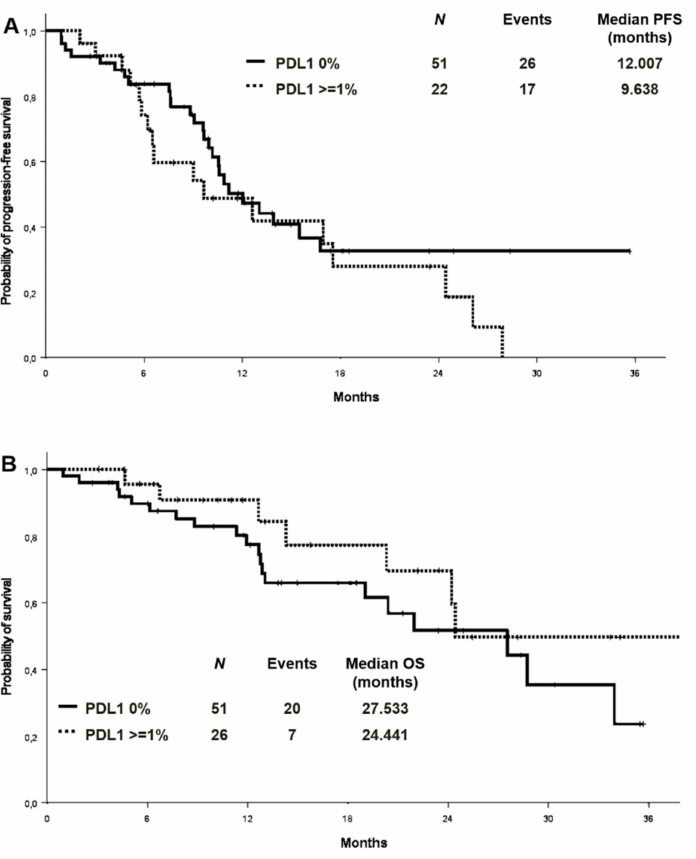
Figure 5. Progression-free survival ( A ) and overall survival ( B ) according to PD-L1 expression. PD-L1: programmed death-ligand